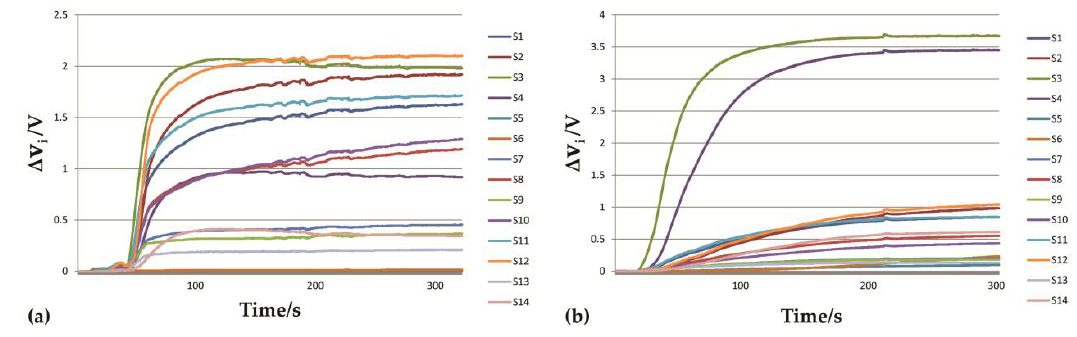
Figure 3. The odor data maps. ( a ) Tetrahydrofuran, ( b ) turpentine. Each curve represents one sensor in the array.